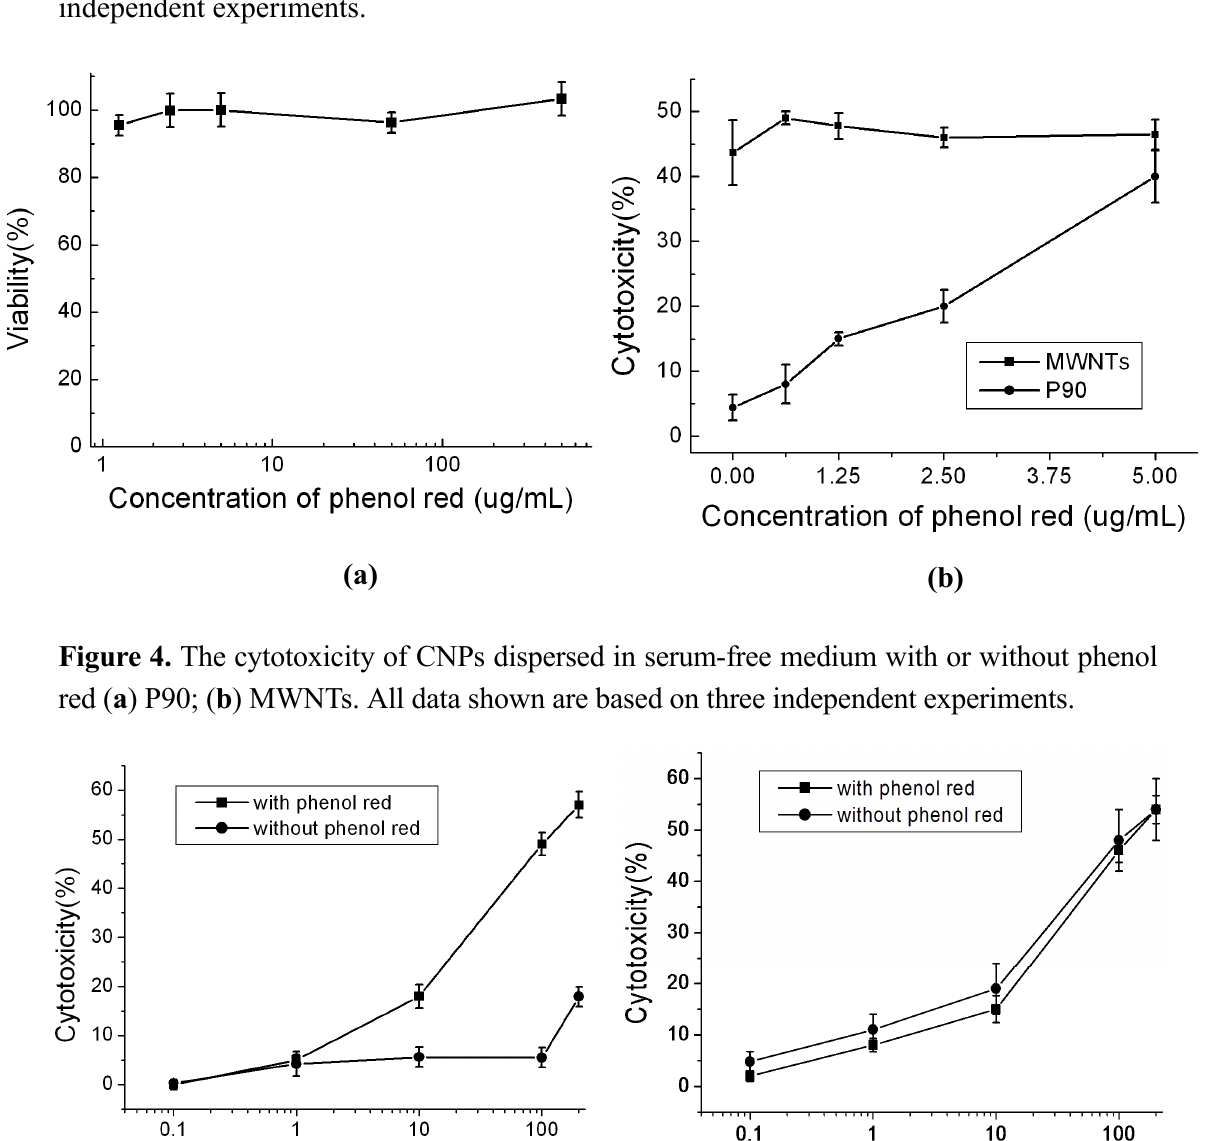
Figure 3. Dose-dependent cytotoxicity of phenol red in serum-free medium ( a ) without CNPs; ( b ) with CNPs at concentration of 100 µg mL − 1 . All data shown are based on three independent experiments.